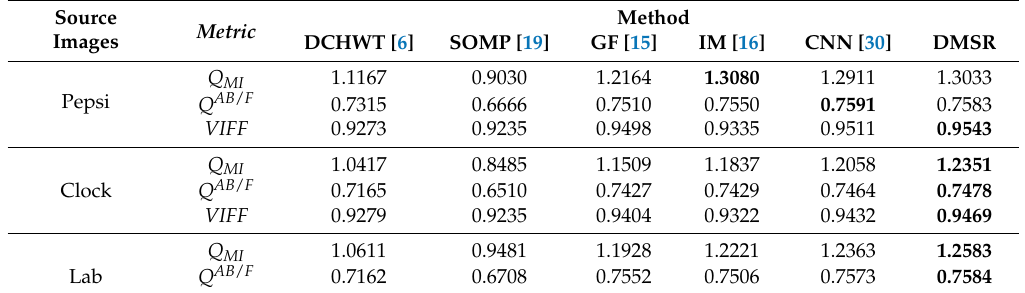
Table 1. Quantitative assessments of different image fusion methods for popular multi-focus images.